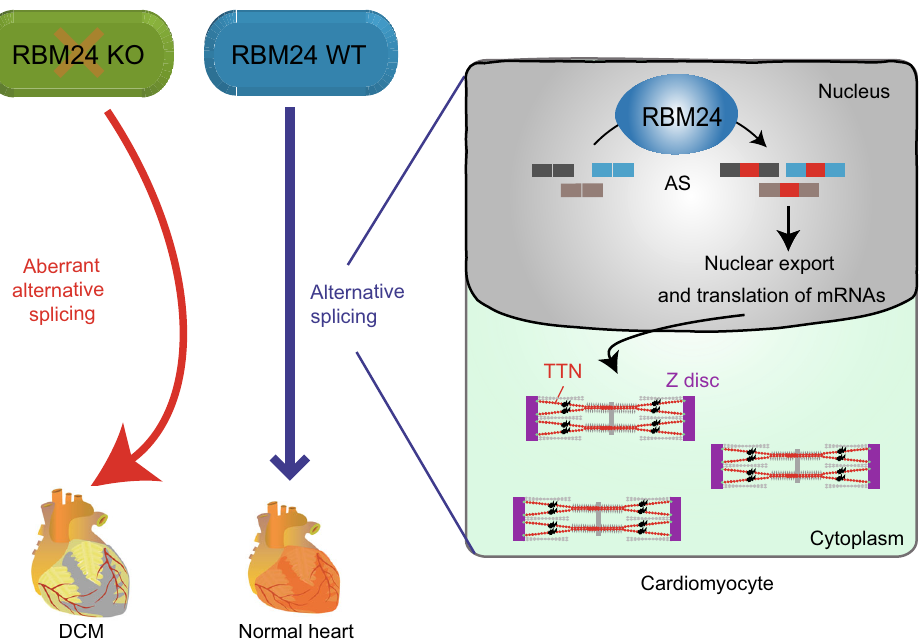
Figure 6. A working model of RBM24 as a key splicing regulator in postnatal heart remodeling. Tissue-speci fi c ablation of RBM24 in the heart disrupts global AS and causes lethal